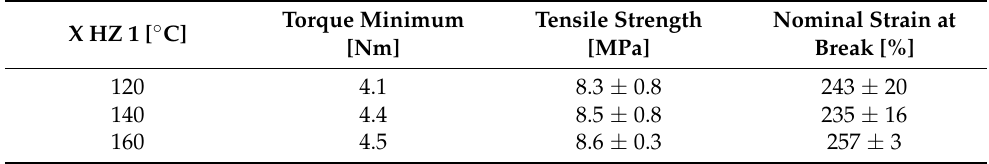
Table 2. Torque minimum, tensile strength, and nominal strain at break of sample S1-2%-E (100 rpm, 3 gpm) as a function of temperature in the first heating zone